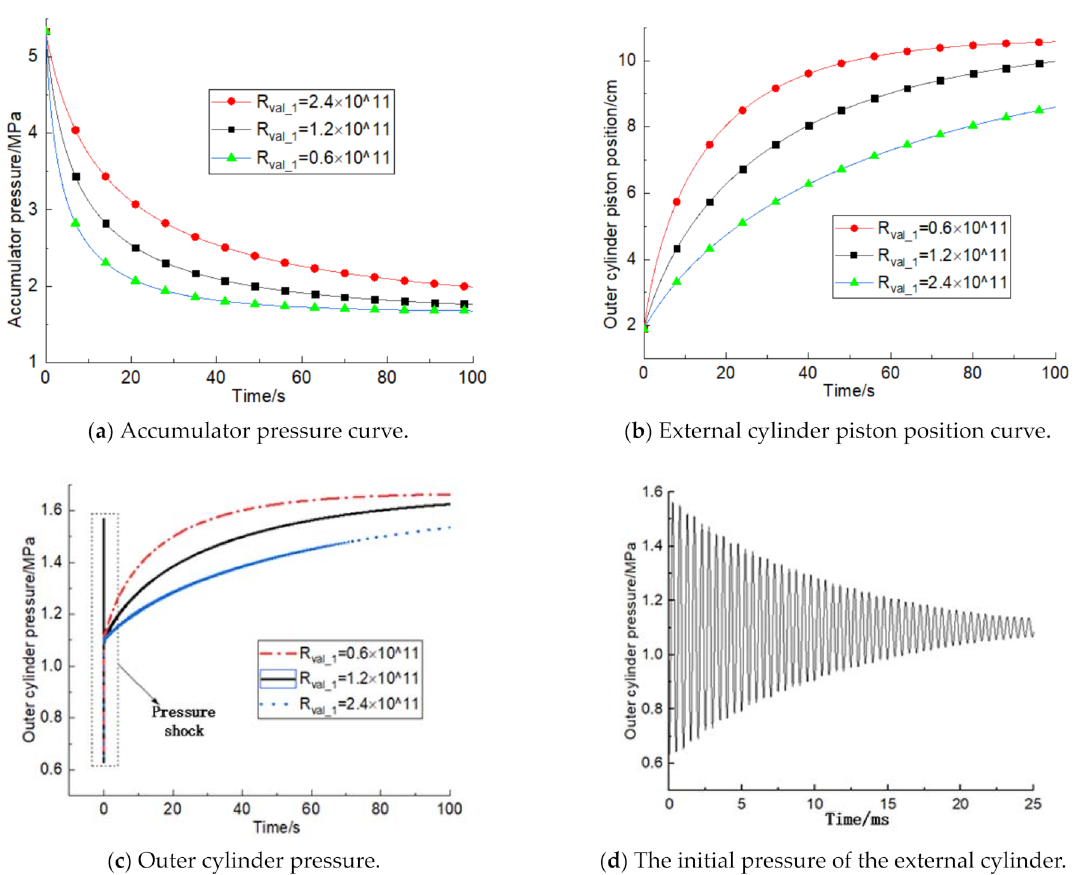
Figure 4. Hydraulic system status curve during floating